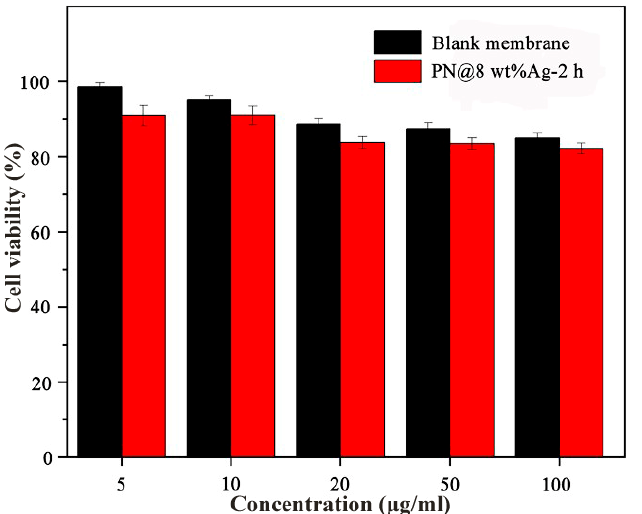
Figure 6. The viabilities of L929 cells after 24 h treatment with the PN@8 wt%Ag-2 h nano fi ber mem-